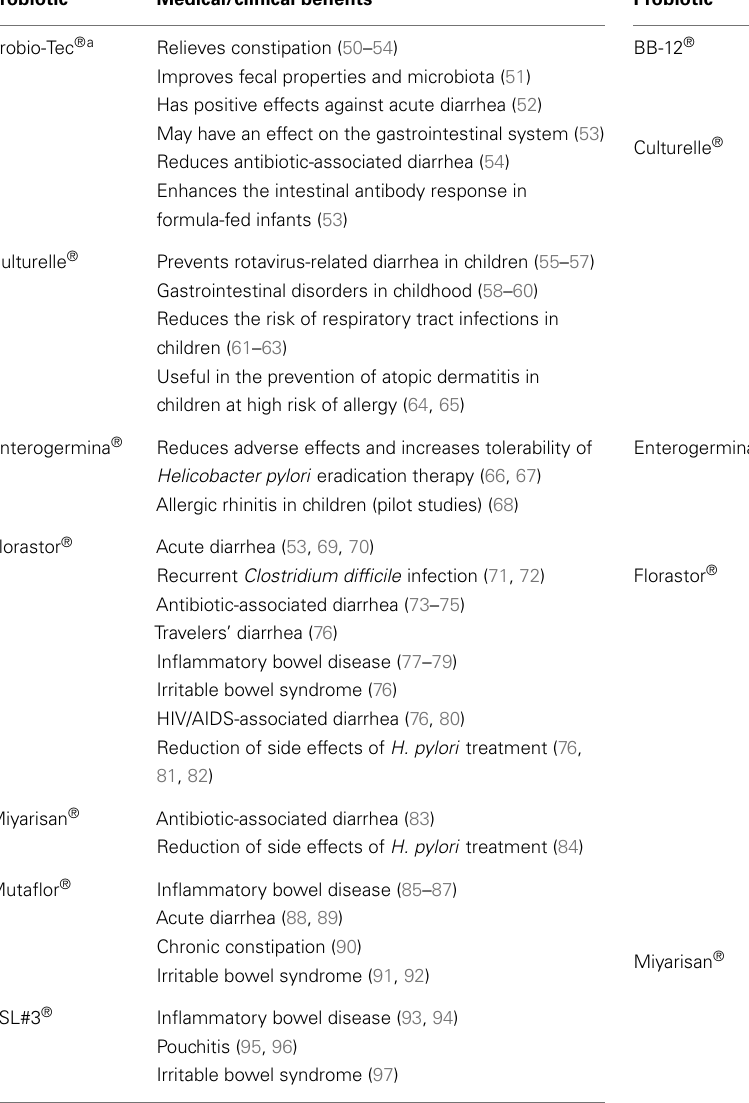
Table 3 | Main mechanisms of action of the major pharmaceutical probiotic products for human